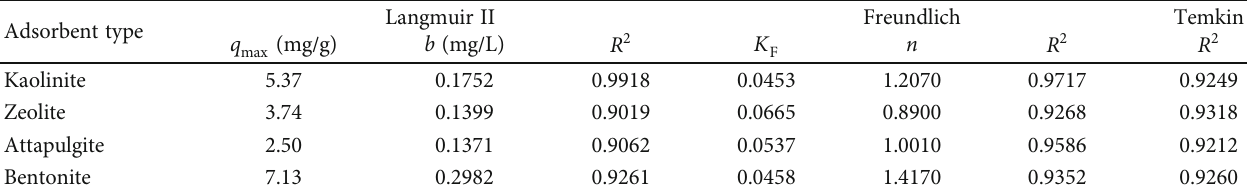
Table 4: Fitting results of the ammonia nitrogen adsorption isotherm.